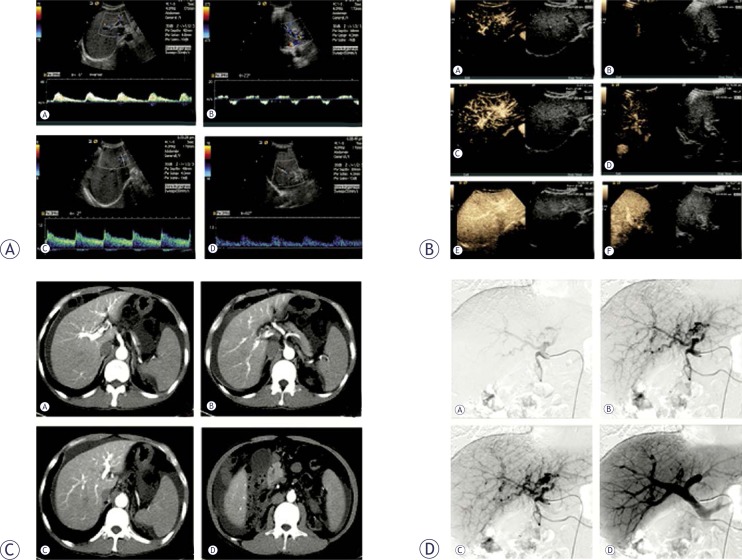
Diffuse intrahepatic APFs with indiscoverable focal lesion, confirmed by multimode imaging findings. (A) Color duplex US images of the intrahepatic branches of the portal vein with normal internal diameter shown as typical arterial-like (a: left branch) or diphase velocity (b: right branch) tracings, as indicated by a systolic hepatofugal dwarf peak and a diastolic hepatopetal low flat shape, and that of the enlarged intrahepatic branches of the hepatic artery, which shows high-velocity flow and low resistivity index (c: left branch, d: right branch). (B) Dynamic CEUS scans show that microbubbles arrived at the affected portal vein and at its parallel running artery in the early arterial phase 7–10 s after SonoVue injection (a: left branch, b: right branch), with the affected portal vein markedly enhanced by the microbubbles during the arterial phase (c: left branch, d: right branch) and which became more echogenic than its surrounding parenchyma until the hepatic veins were stained (e: left branch, f: right branch). (C) The contrast-enhanced CT images show an earlier enhancement of the affected portal vein than that of the superior mesenteric vein during the arterial phase (a: right anterior branch, b: right posterior branch, c: left branch, d: the enhancement of the superior mesenteric artery but no enhancement of its parallel running vein). (D) DSA reveals the opacification of the portal vein following its parallel running artery but no visible fistula during the early arterial phase (a: opacification of hepatic artery, b: opacification of peripheric portal vein, c: opacification of left and right branches of portal vein, d: opacification of superior mesenteric and splenic vein).